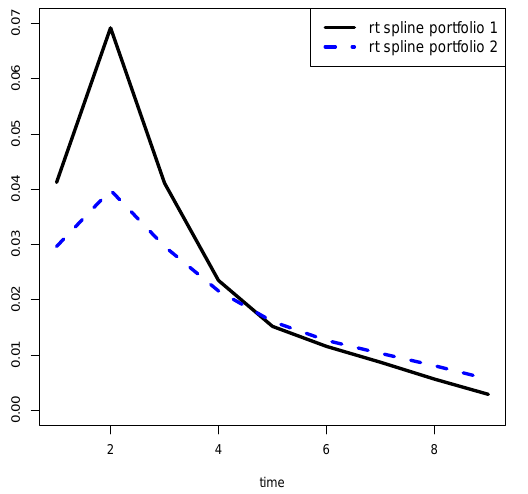
Figure 9. Comparison of recovery curve in term of r t for portfolio 1 and portfolio 2.